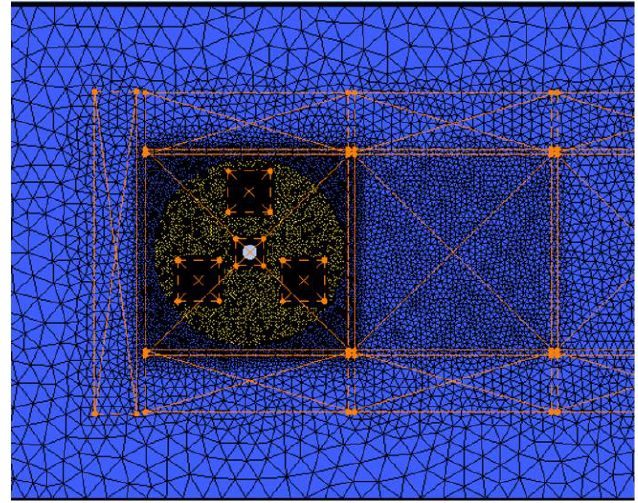
Figure 3. Fine mesh with density box detail.